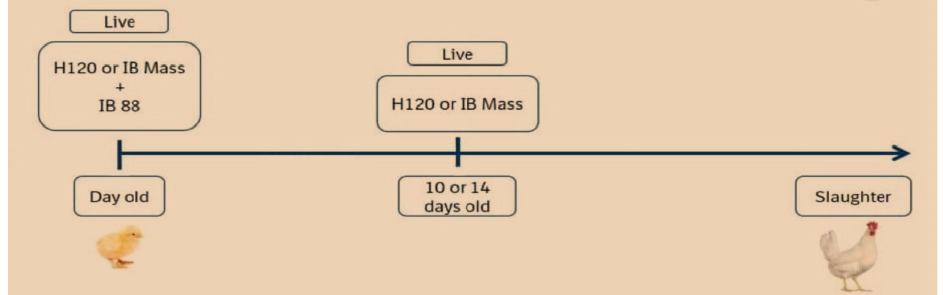
Figure 1. IBV live attenuated vaccination program in broiler chicken with different serotypes widely used in challenge areas for providing stronger protection against several IBV